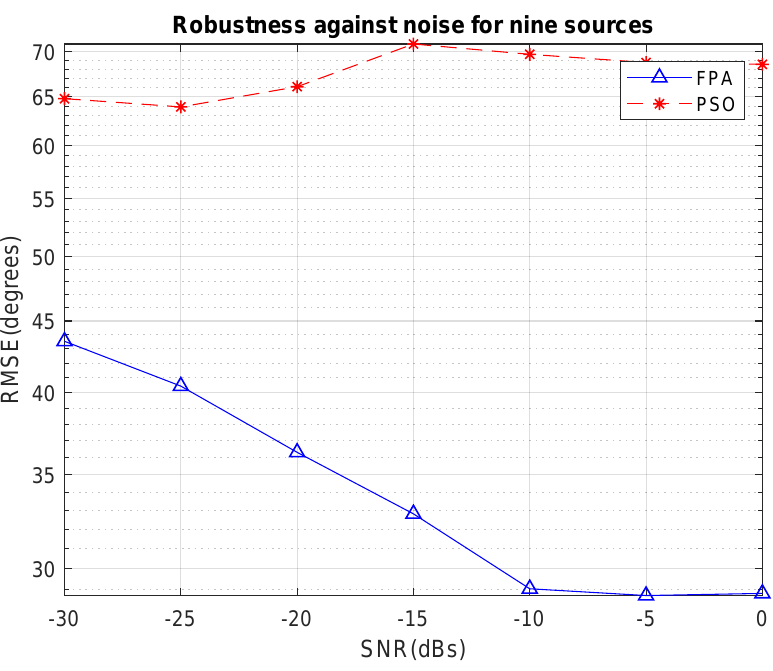
Figure 6. Robustness against noise for eleven